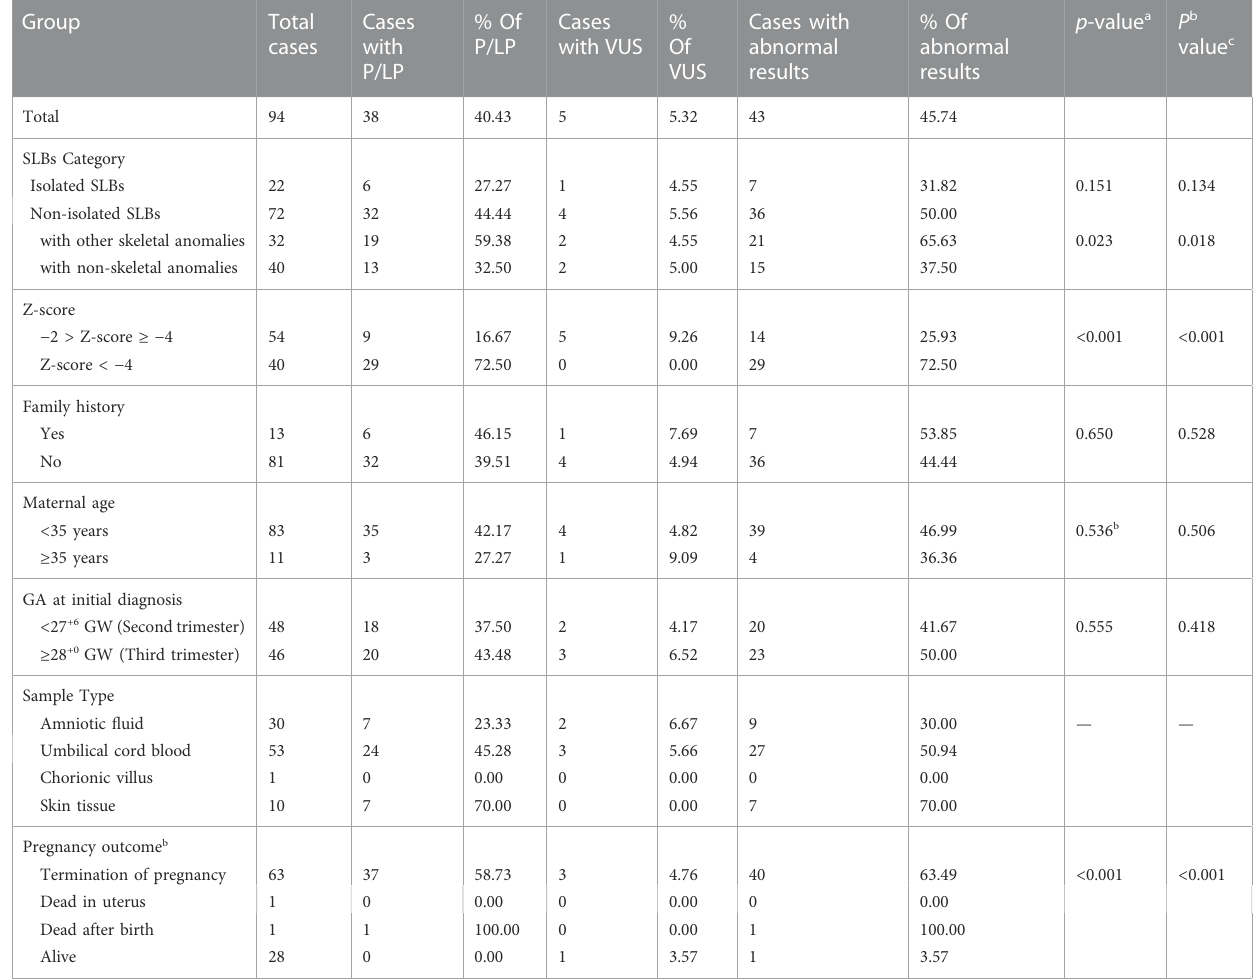
TABLE 2 The yield of exome sequencing according to clinical